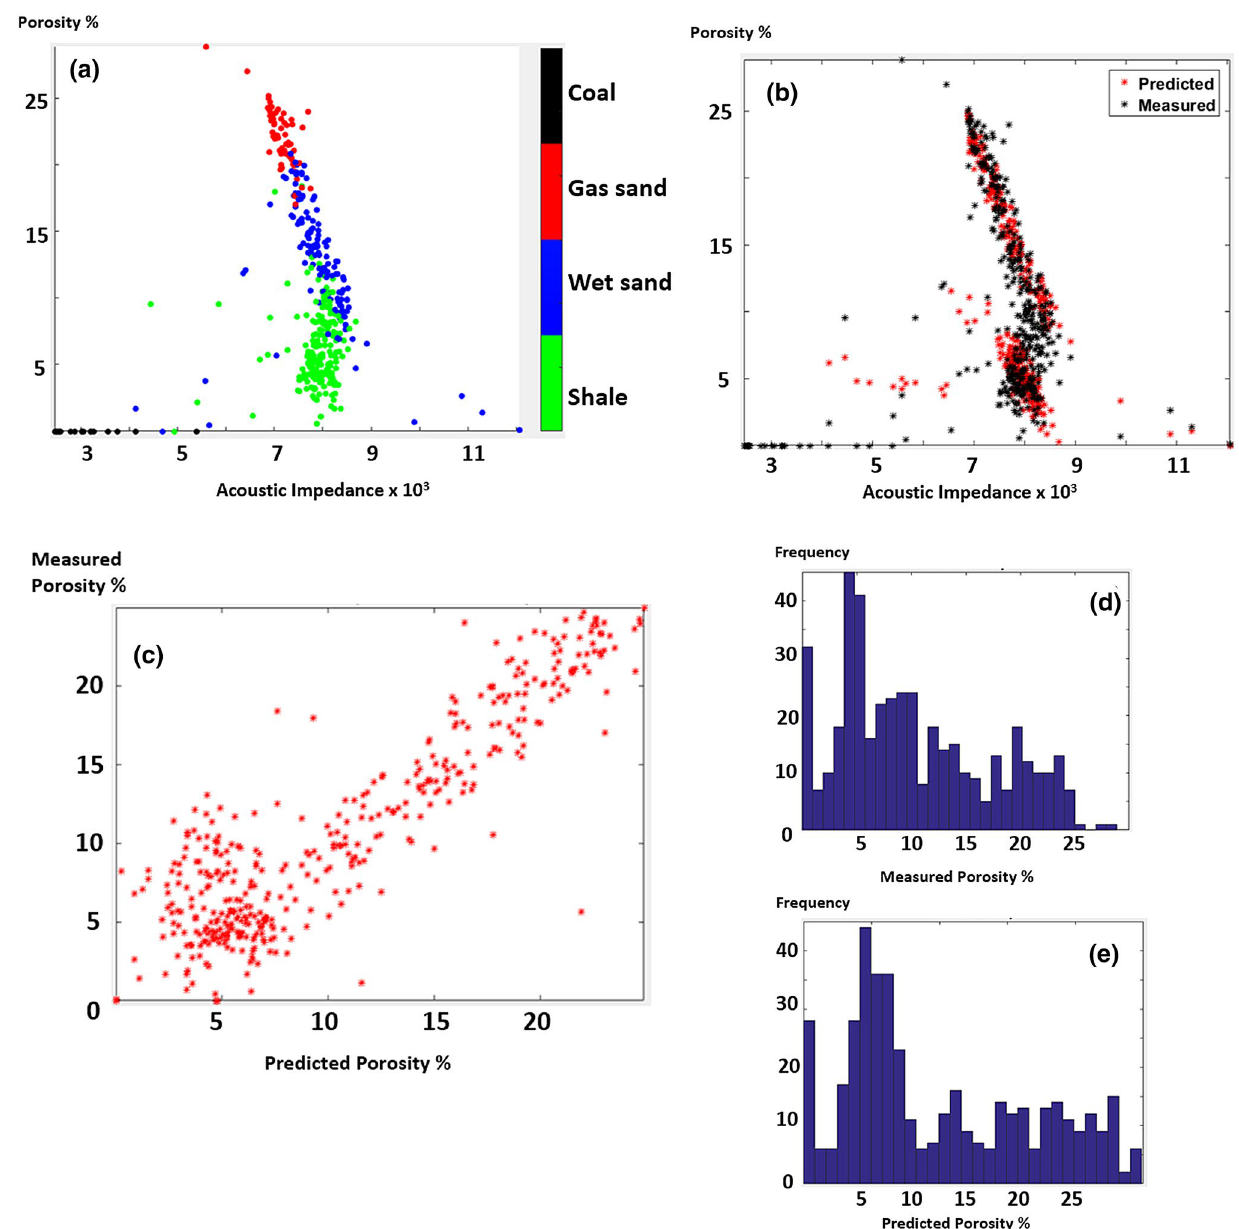
Fig. 3 a Cross-plot of acoustic impedance (m/s * gr/cc) versus poros- ity (%) at well location color coded by lithofacies classes. b Overlay comparison cross-plot of acoustic impedance versus porosity, meas-